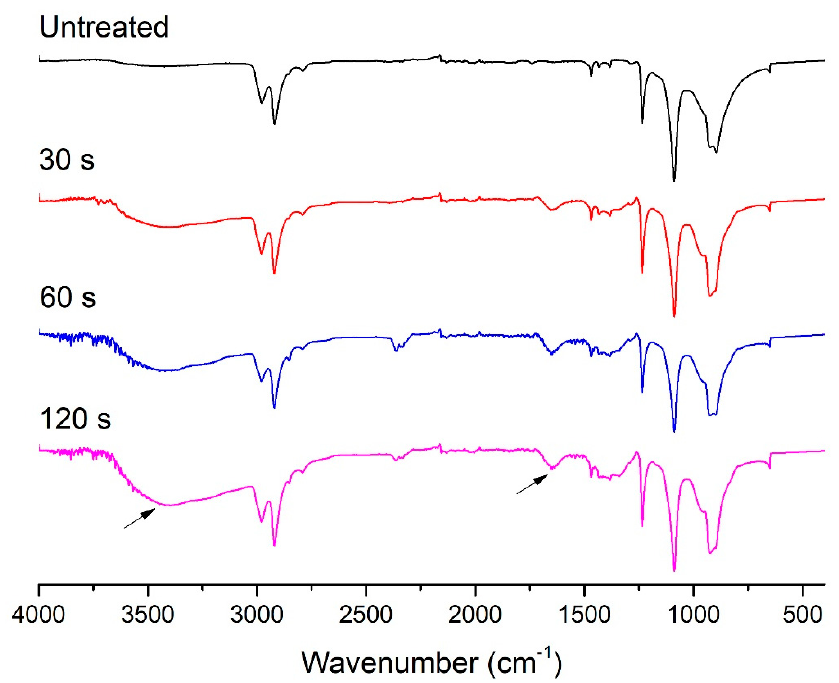
Figure 4. FTIR spectrum of untreated POM fiber and fiber subjected to DBD plasma treatment for different durations.